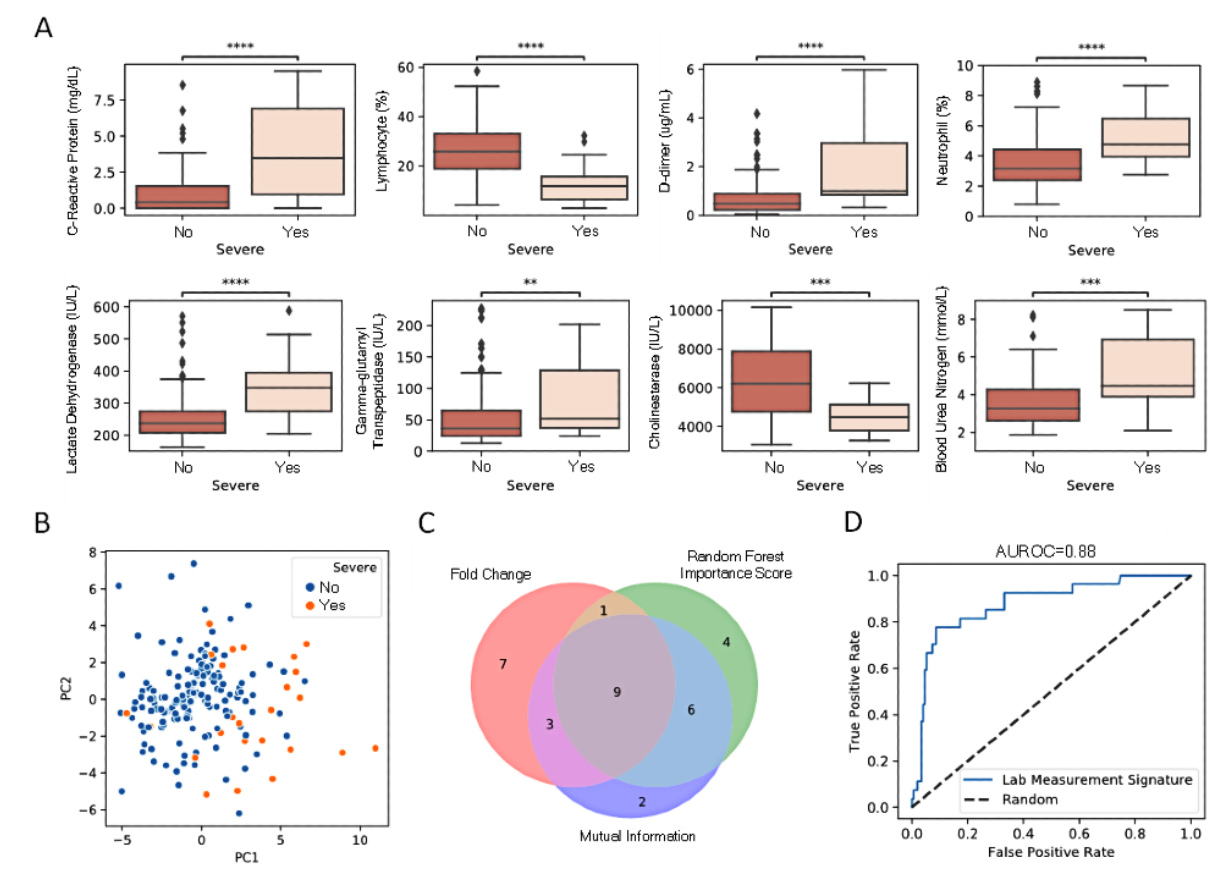
Figure 1. Correlation of laboratory tests with COVID-19 severity. (A) Top-8 laboratory tests ranked by fold change. (B) Principal component (PC) analysis of all laboratory tests. (C) Venn diagram of the top features selected by 3 different approaches: random forest importance score, mutual information, and fold change. (D) Area under receiver operating characteristic of classification using a signature of 12 laboratory tests. The asterisk annotations denote the following: * 1.00e-02<P ≤ 5.00e-02, ** 1.00e-03<P ≤ 1.00e-02, *** 1.00e-04<P ≤ 1.00e-03, **** for P ≤